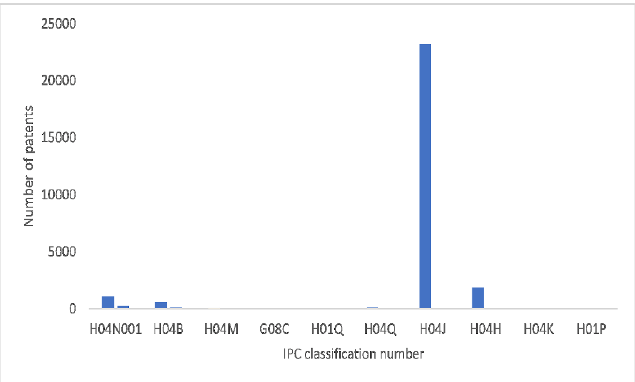
Fig. 1 Quantity distribution of AI patents in different years.